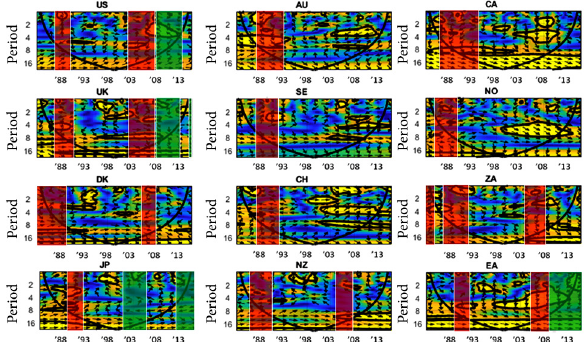
Figure 4. Wavelet coherency between M3 money growth and house price inflation from 1Q 1984 to 4Q 2016 (source: own